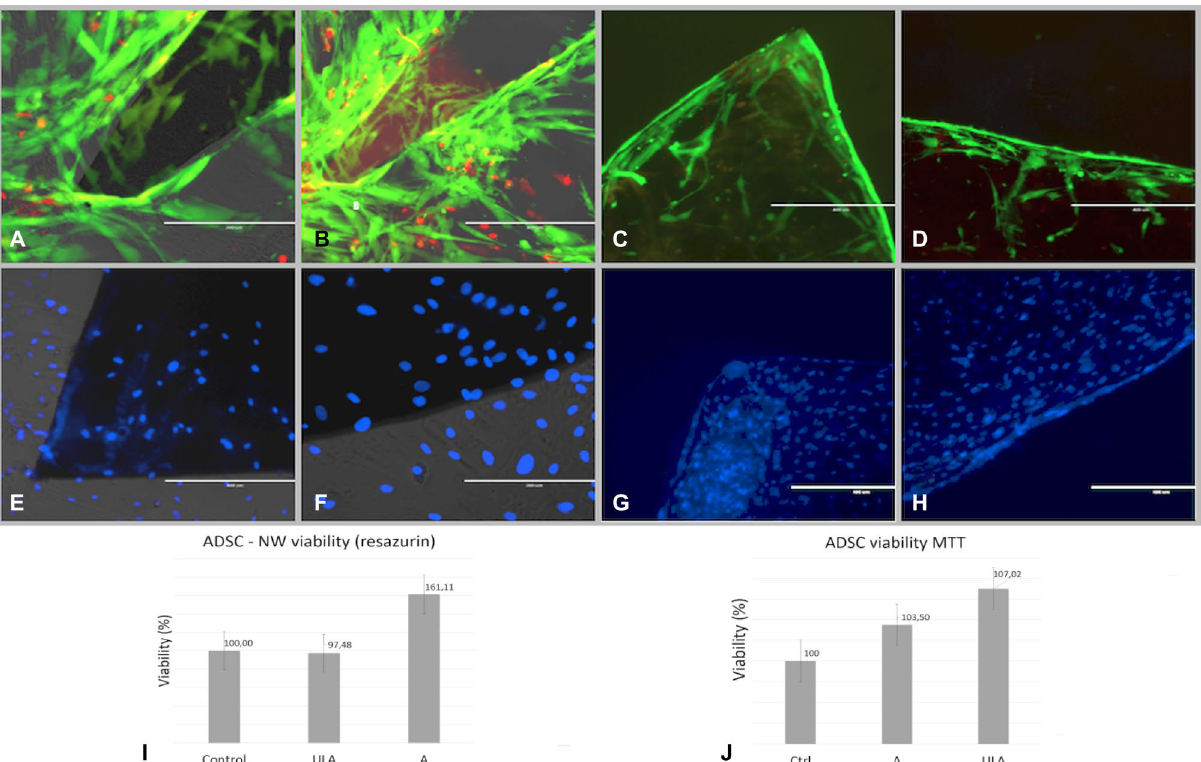
Figure 4. ASCs cultured on nanowire as substrate: in adherent plates ( A , B , E , F ); ( A , B ) life dead staining of ASCs cultured on nanowire substrate after 48 h, good cell viability—in green fluorescent calcein staining of viable cells in red—ethidium bromide fluorescent staining of non-viable cells; ( E ), ( F ) nuclear staining with DAPI demonstrating cells are capable to adhere on both plastic culture dish surface as well as on nanowire substrate: in non-adherent plates ( C , D , G , H ); ( C , D ) life dead staining of ASCs cultured on NW substrate after 48 h demonstrating good cell viability with very few red non-viable elements; ( G , H ), nuclear staining demonstrate cells adhere on NW but not on cell culture plastic surface; ( I ) ASCs viability on Nanowire substrate assessed with Resazurin assay; ( J ) ASCs viability assessed with MTT assay; A = Adherent plates ULA = ultralow adherent plates NW = nanowire